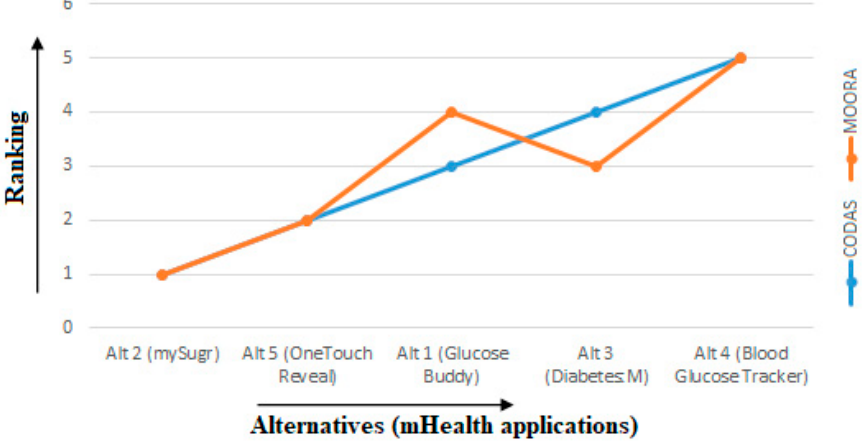
Figure 8. Comparison result of the rankings of the alternatives using CODAS and MOORA .